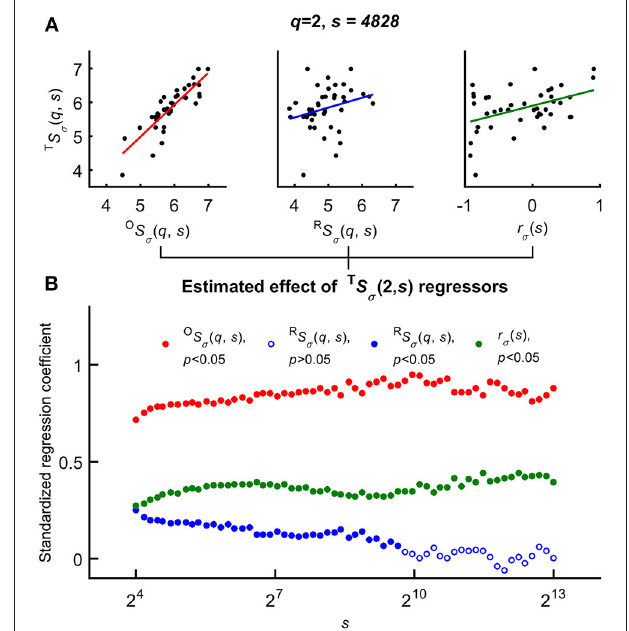
FIGURE 6 | Significance of multiple regression tests. (A) Scaling function value of HbT as a function of O S ( q , s ) (left), R S ( q , s ) (middle) and scale-wise fractal cross-correlation coefficient (right) acquired at equal scale and moment (exemplary case at q = 2 and s = 4828). (B) Regression coefficients and their significance (closed circle for cases of p < 0.05) related to scaling function values of HbO, HbR; and r σ as functions of scale s . The estimated effect were significant for all s values in case of O S ( q and r σ ( s ), and the lower standardized regression coefficients indicated the weak (not significant for all scales) effect of R S ( q , s ). For further details, see main